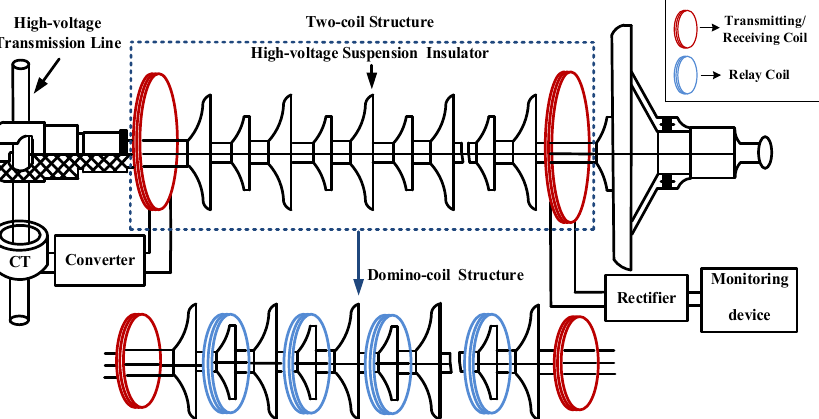
Figure 1. Block diagram of the traditional two-stage and domino-type WPT system used on HVTL.